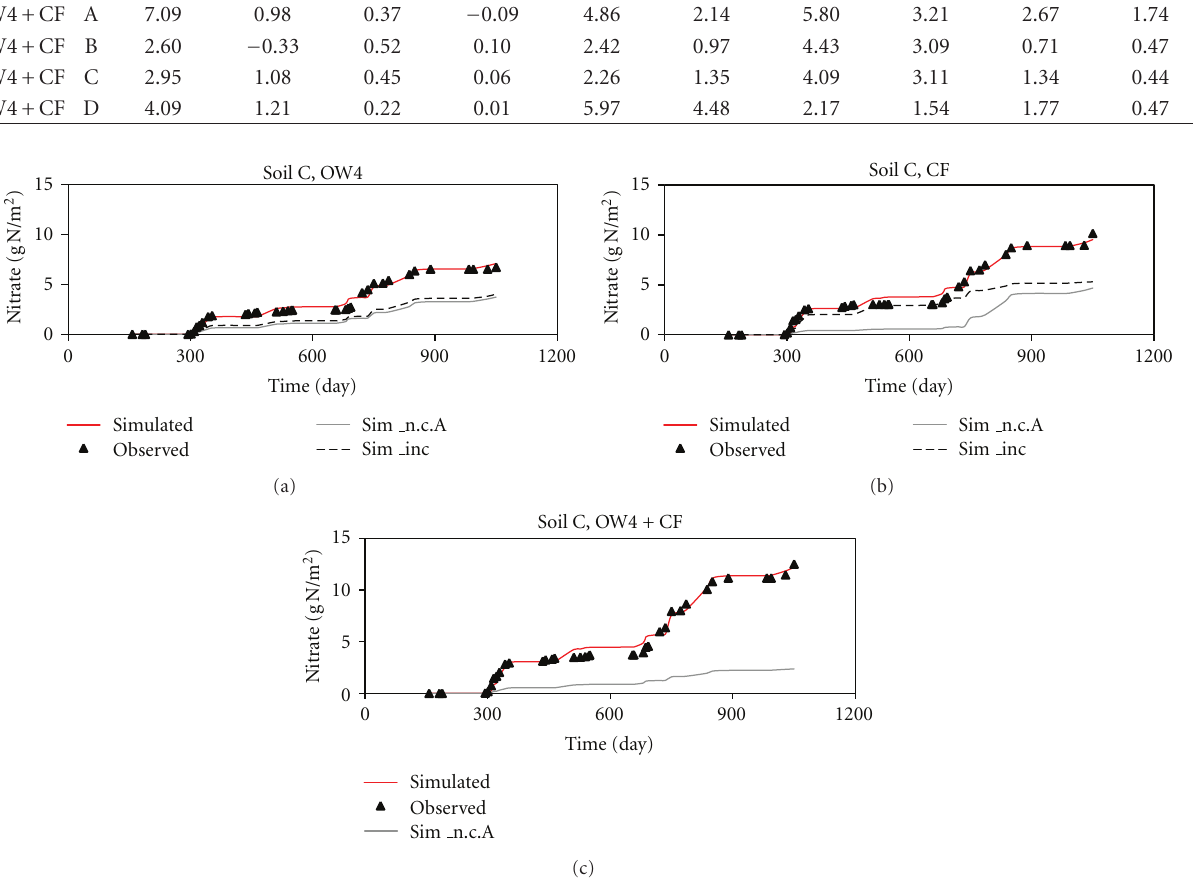
Figure 5: Application of organic matter to soil C. Simulated and observed NO 3 − -N leaching [gNm − 2 ] (accumulated values). Broken line indicates simulation with no calibration of management routine